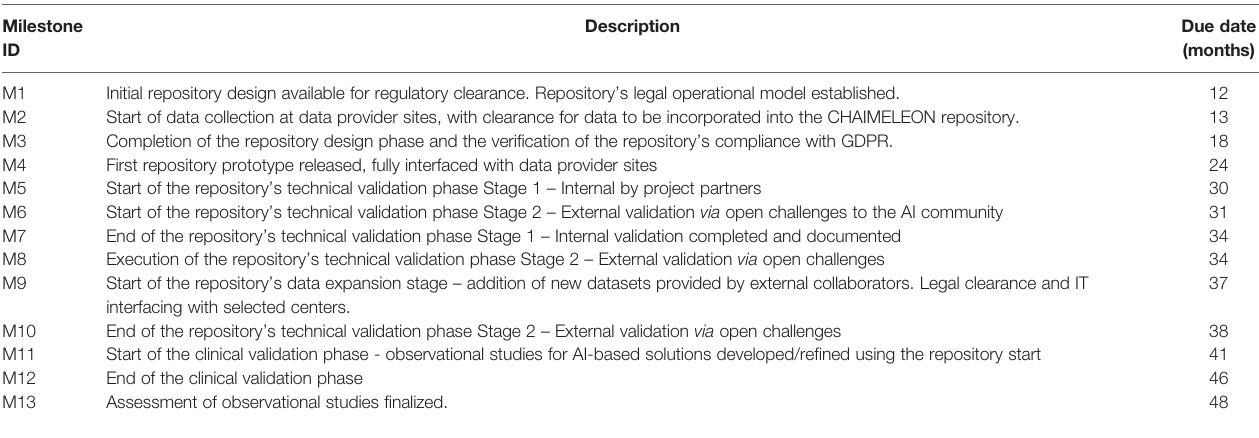
TABLE 1 | Project